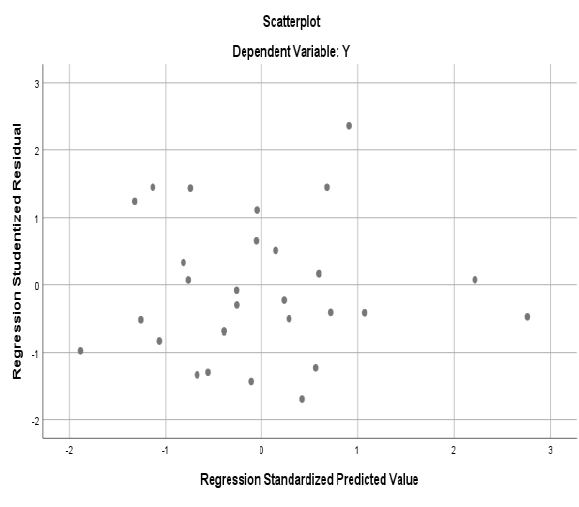
Figure 4: Heteroscedasticity